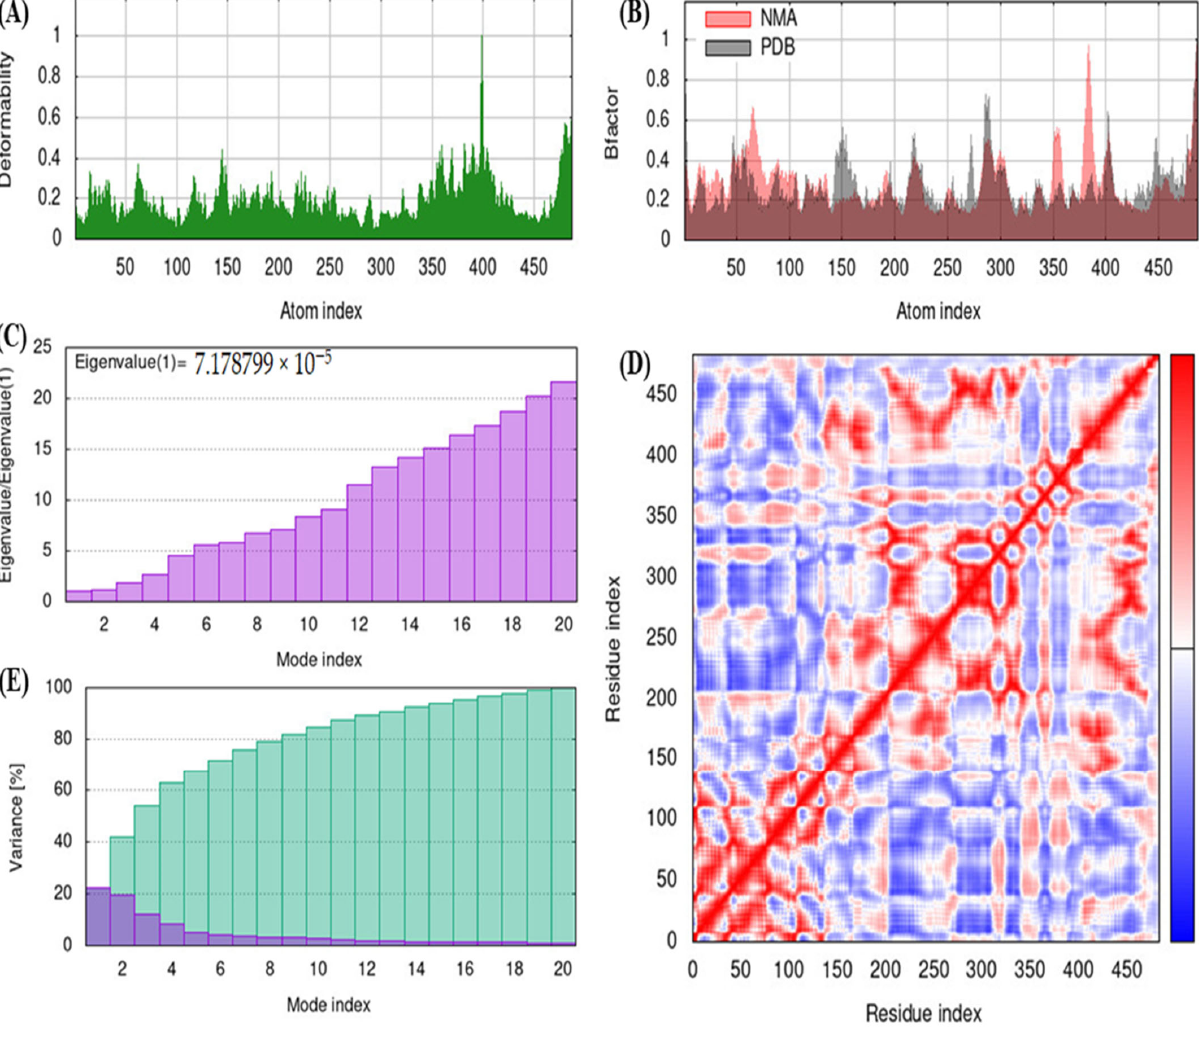
Figure 7. Molecular dynamics. ( A ) Deformity analysis, ( B ) B ‐ factor, ( C ) Eigen values, ( D ) Covariance map and ( E ) Variance.